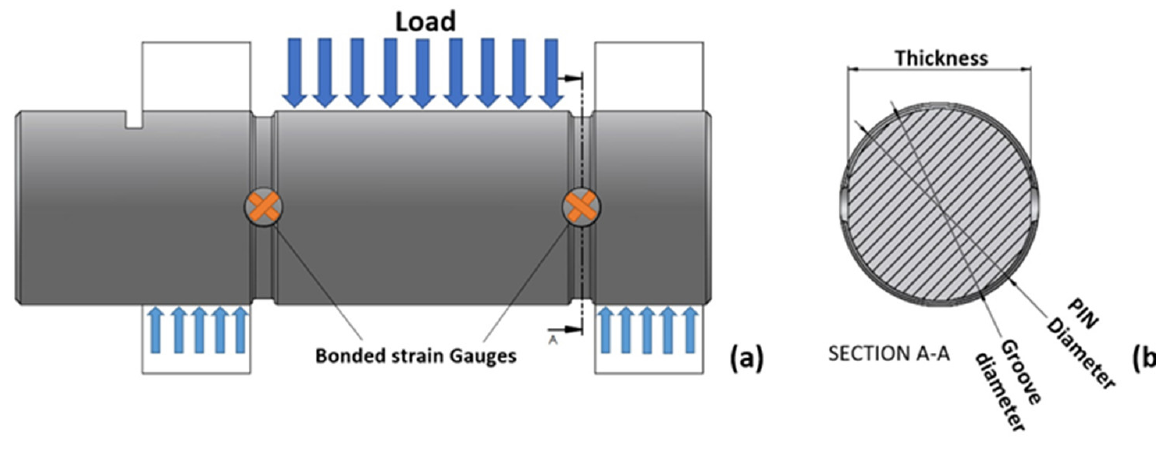
Figure 2. ( a ) Strain gauges on loaded cylindrical pin, and ( b ) cross-sectional area at grooves.